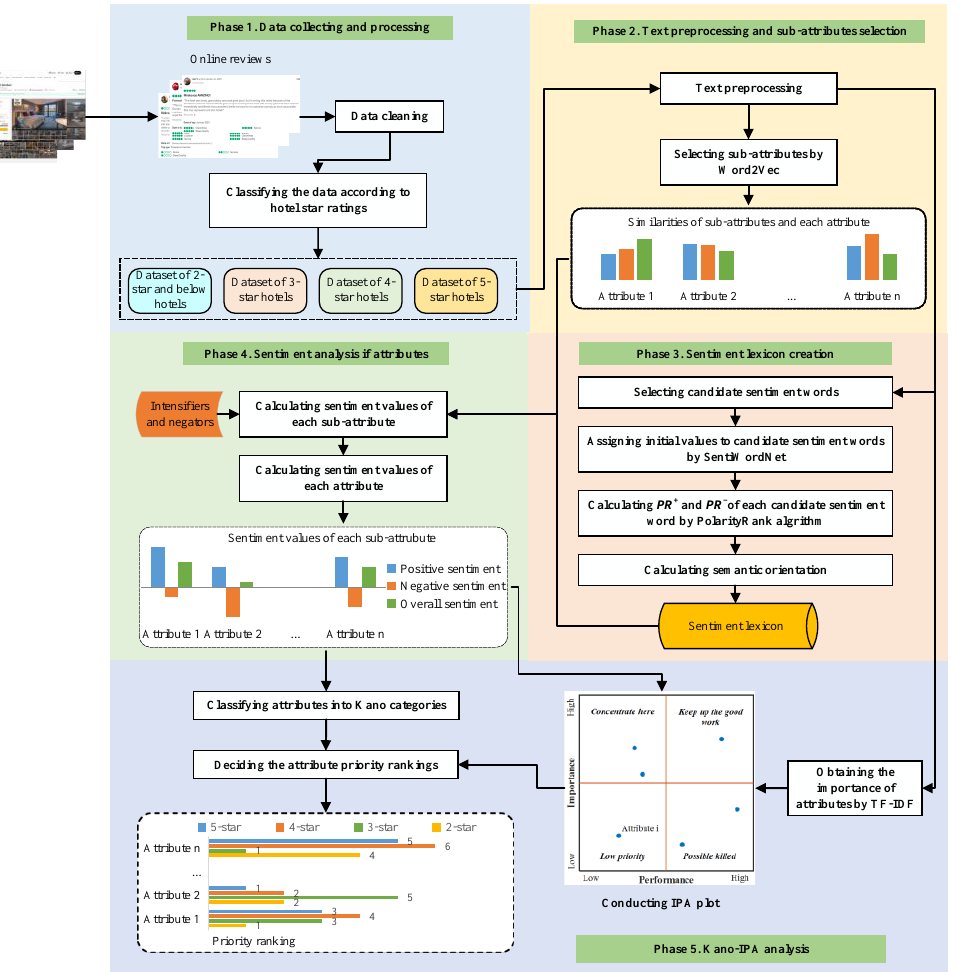
Figure 3. Framework of the proposed methodology.